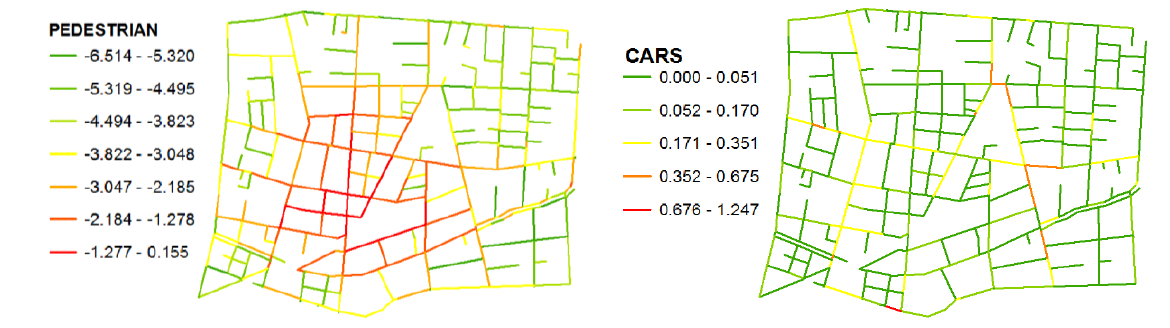
Figure 2. Values of each